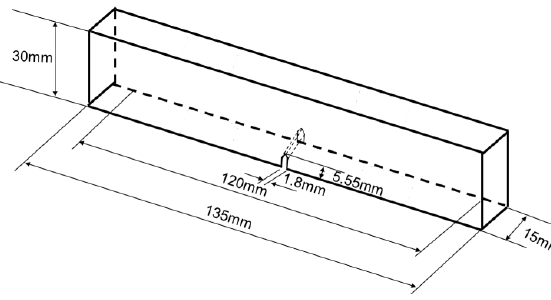
Figure 15. Sizes of the six specimens for three-point bending test.